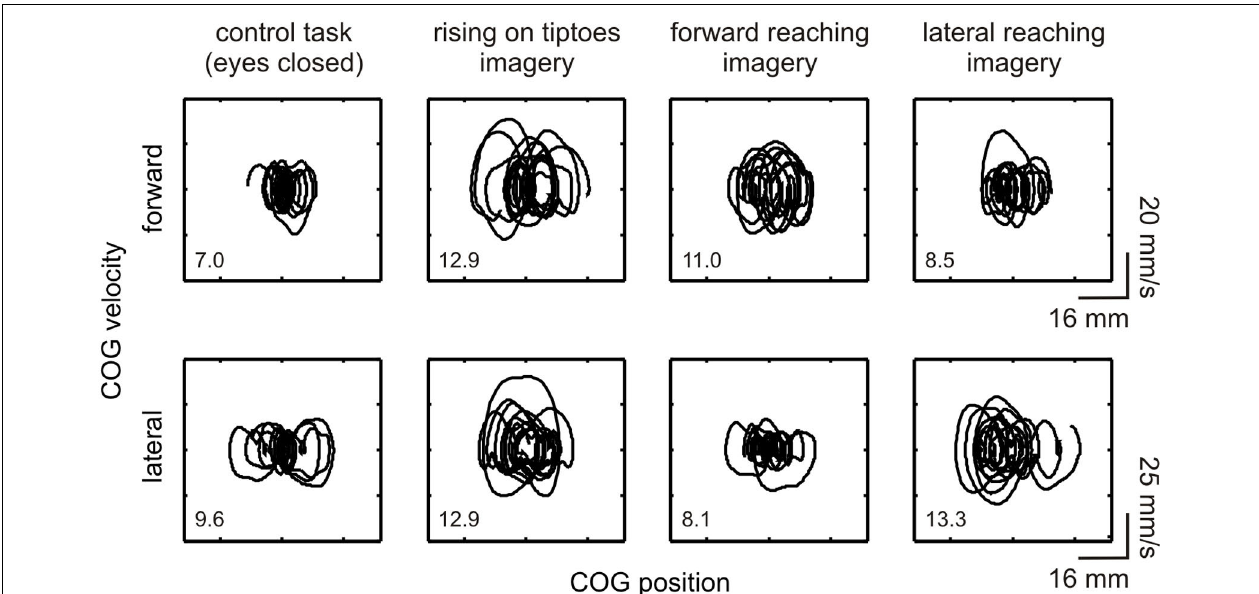
FIGURE 2 | Effect of motor imagery on COG variability. COG phase-plane plots from a representative subject (#11) are shown during control and imagery tasks (as indicated under each column). Plots are shown for the forward-backward (indicated as “forward,” upper plots) and lateral (lower plots) directions. Correspondent directional stability values